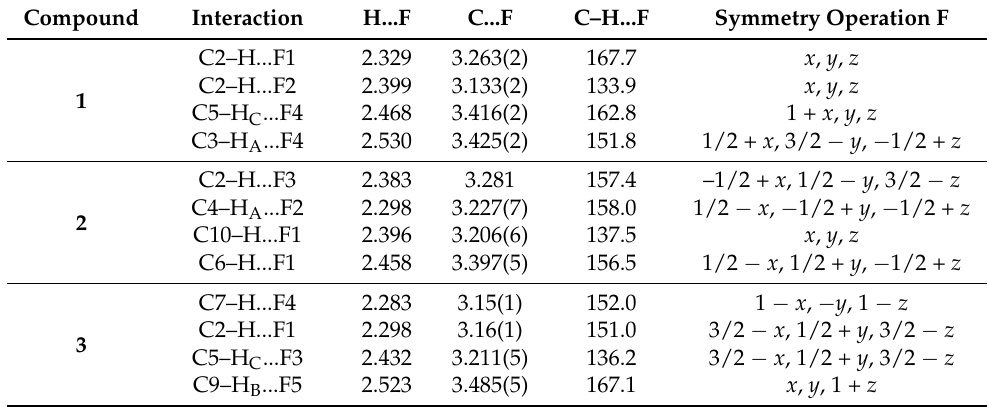
Table 3. C–H...F interactions in compounds 1 – 3 (Å, °).